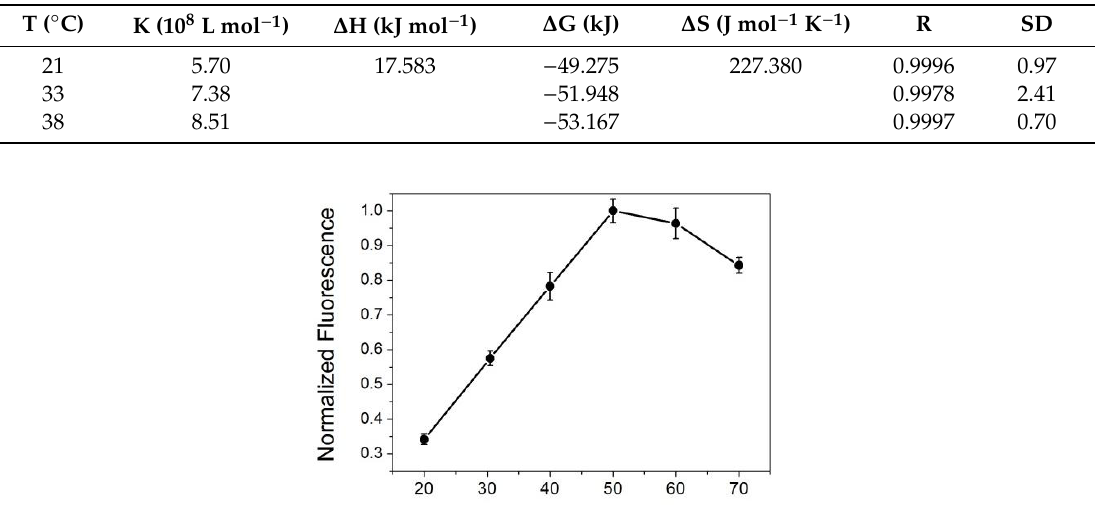
Table 1. Calculated thermodynamic parameters for ATT-AuNCs-BSA composite. Figure 3. The thermodynamics curve of ATT-AuNCs (8 μM) after introducing BSA (35 μg/mL). Error Figure 3. The thermodynamics curve of ATT-AuNCs (8 µ M) after introducing BSA (35 µ g / mL). Error bars represent the standard deviations across three repetitive experiments. bars represent the standard deviations across three repetitive